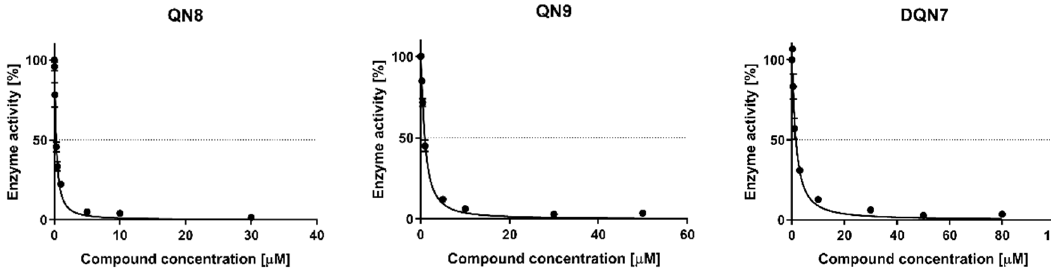
Figure 4. IC 50 determination for hr AChE inhibition by QN8 , QN9 , and DQN7 .